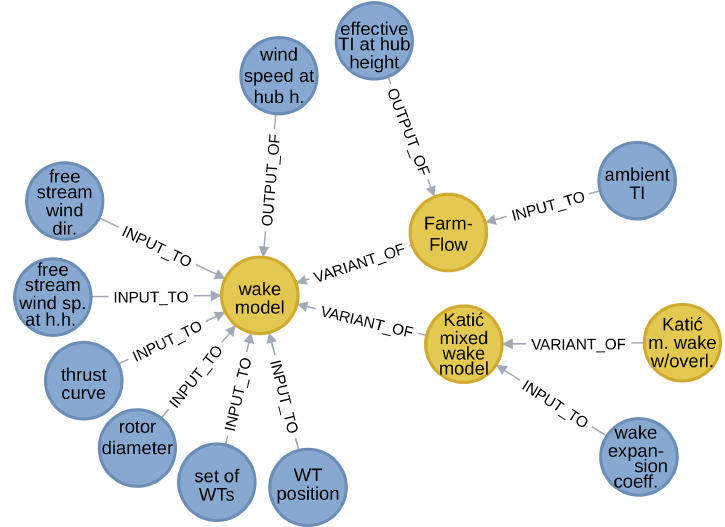
Figure 16. Example of an ordered set of variant models and their variables (excerpt from WESgraph).